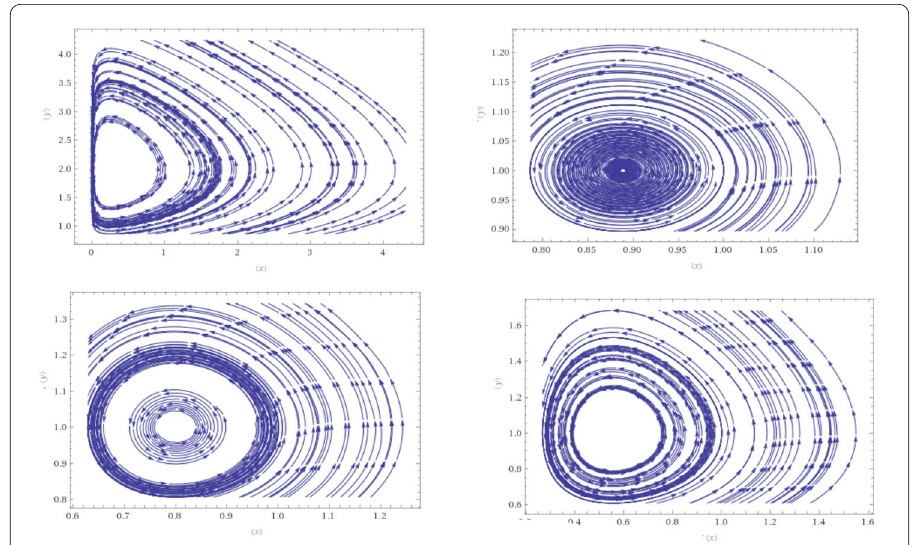
Figure 1 Results of (3) with various values of ρ . From the upper left, the solution is for ( υ